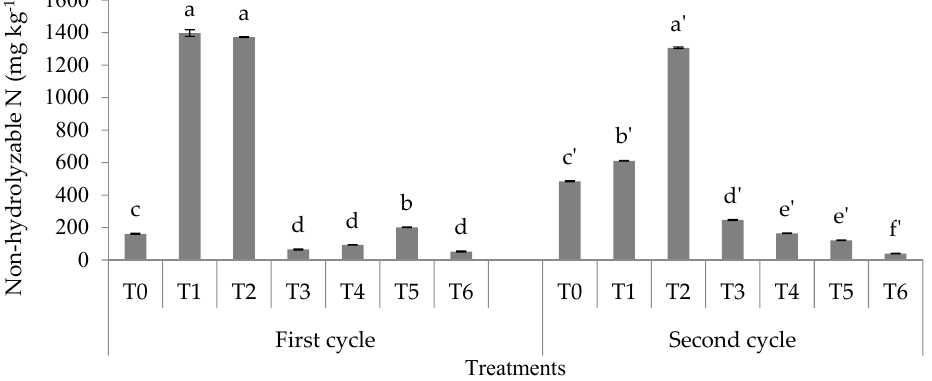
Figure 7. Effects of treatments on soil non-hydrolyzable nitrogen. Means with the same letter above the bars within a crop cycle are not significantly different at p ≤ 0.05. Bars represent the mean values ± standard error .